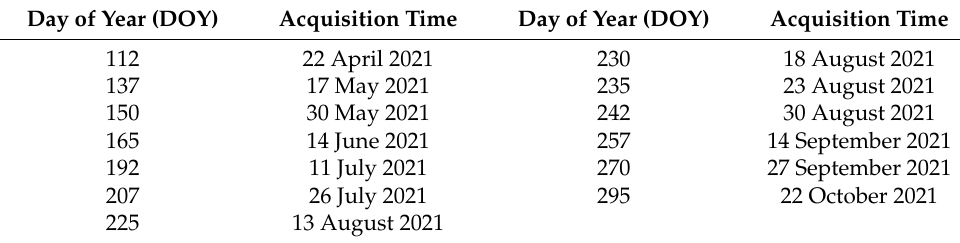
Table 2. Acquisition time of Sentinel-2 images.